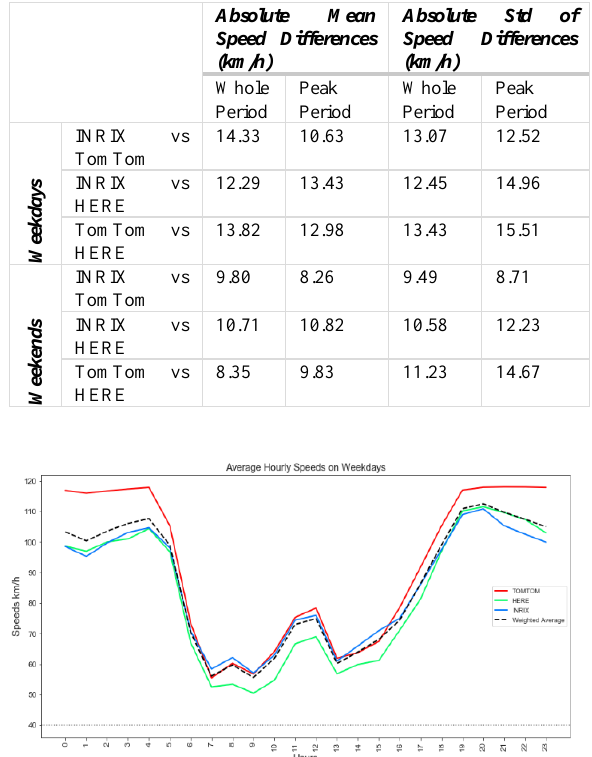
Table 2:Absolute mean and standard deviations of FCD speeds over different periods for the entire road section